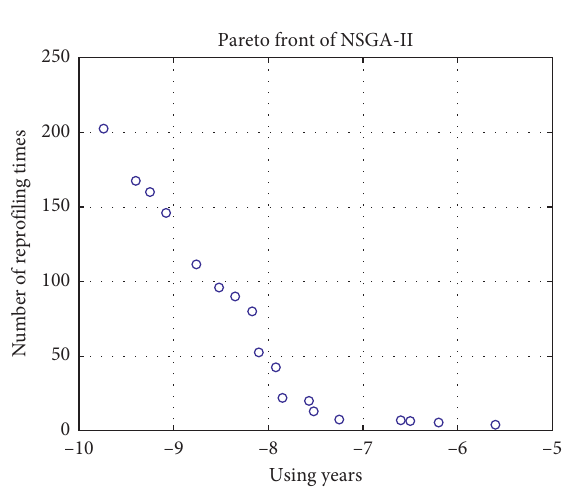
Figure 11: Results of